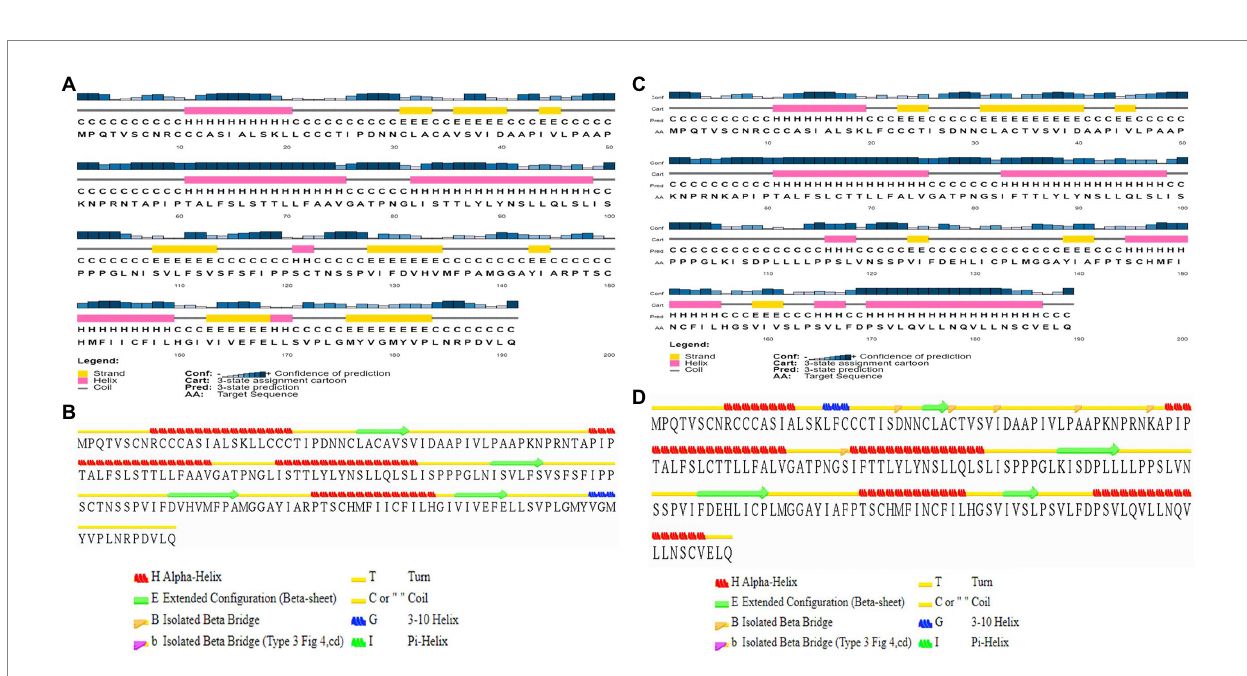
FIGURE 2 Sequence-based secondary structure prediction. (A) Sequence-based secondary structure assignment for ASP_Indie-C1 using PSI-PRED; (B) Secondary structure of the modeled ASP_Indie-C1 predicted using STRIDE; (C) Sequence-based secondary structure assignment for ASP_NL4-3 using PSIPRED; and (D) Secondary structure of the modeled ASP_NL4-3 predicted using